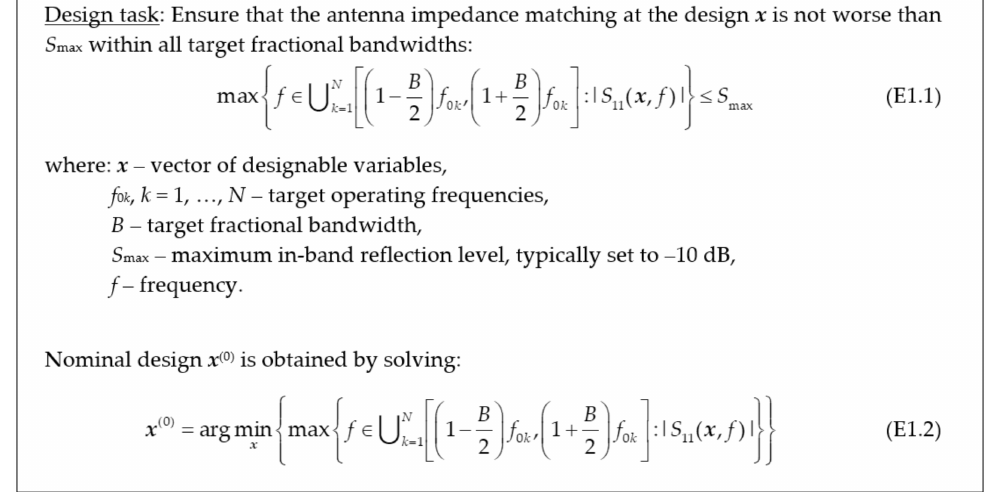
Figure 1. Example I: Multiple-band antenna optimized for best in-band matching.